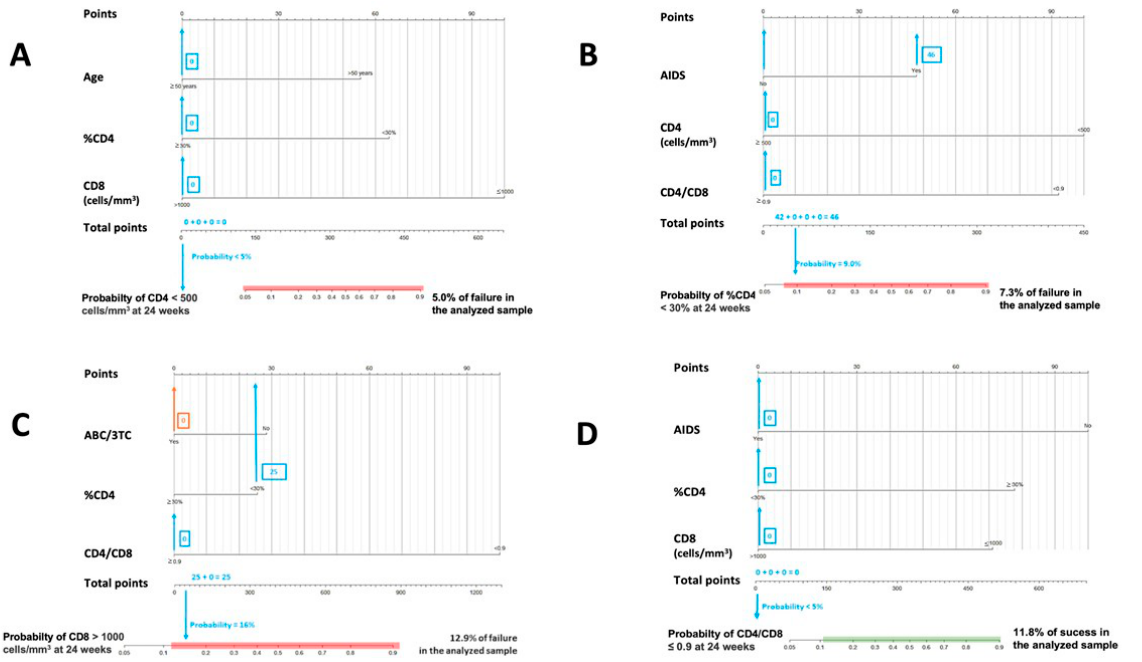
Figure 2. Nomograms to predict the probability of failure at 24 weeks. ( A ) Nomogram to predict the probability of achieving CD4 < 500 cells/mm 3 at 24 weeks in PLWHIV treated with DTG plus 3TC with basal CD4 values ≥ 500 cells/mm 3 ; ( B ) nomogram to predict the probability of achieving CD4 < 30% at 24 weeks in PLWHIV treated with DTG plus 3TC and with basal ≥ %CD4 30%; ( C ) nomogram to predict the probability of achieving CD8 > 1100 cells/mm 3 at 24 weeks in PLWHIV treated with DTG plus 3TC and with basal CD8 ≤ 1100 cells/mm 3 ; ( D ) nomogram to predict the probability of achieving CD4/CD8 ≤ 0.9 at 24 weeks in PLWHIV treated with DTG plus 3TC and with basal CD4/CD8 > 0.9.